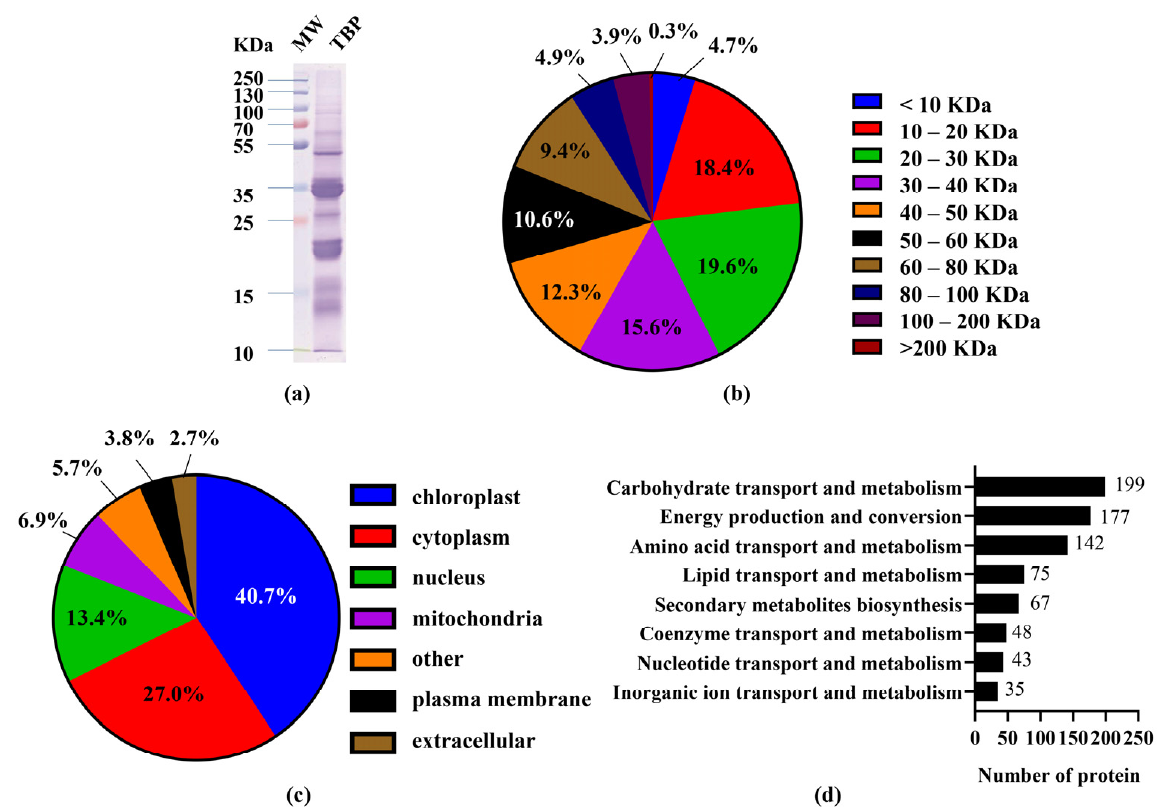
Figure 2. ( a ) SDS-PAGE of TBP; MW, molecular weight marker. ( b ) Molecular weight distribution of the identified proteins in TBP. ( c ) Distribution of the identified proteins in the organelles of TBP. ( d ) Metabolism-related functions of the identified proteins in TBP based on COG/KOG functional classification.